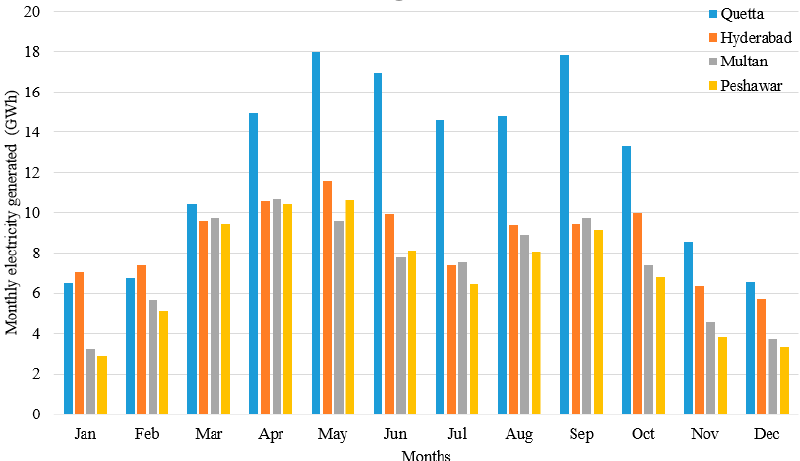
Figure 13. Electricity production by the 50 MWe PT plant with evaporative cooling for different regions. Table 5. Performance parameters of the 50 MWe PT plant with evaporative cooling.